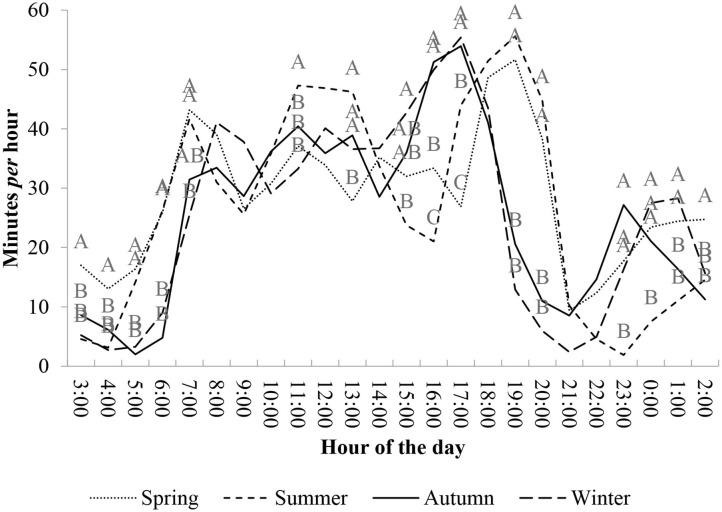
Mean foraging time (minutes per hour) of beef heifers, over 24 h, managed in natural grassland under rotational grazing method among the four climatic seasons over the years of 2010–2012 (*different capital letters in a column differ by Tukey test at 5%).